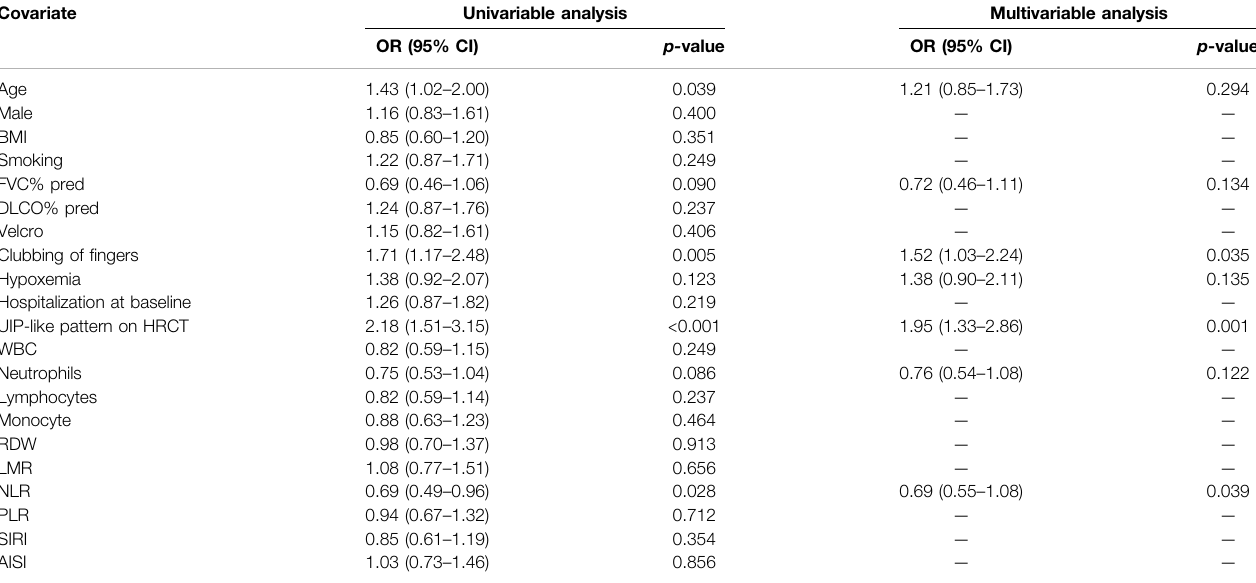
TABLE 3 | Factors associated with progressive fi brosing.